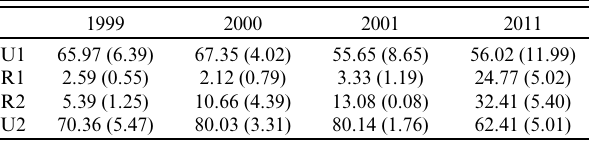
Table 2 . Mean percent fine sediment (standard error) in riffle habitat of four reaches of Juday Creek.